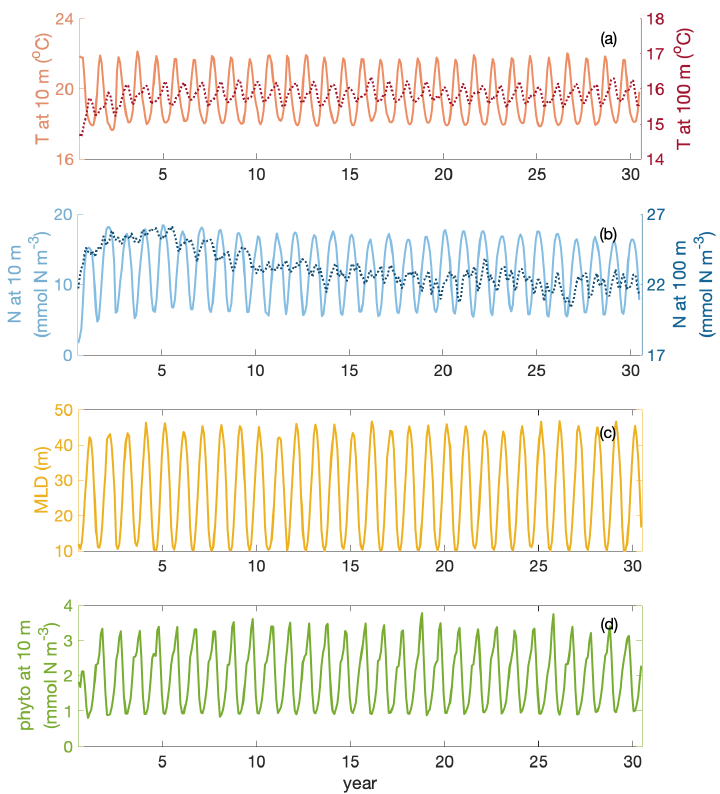
Figure C1. Time series of temperature T (at 10 and 100m depth), nitrate N (at 10 and 100m depth), mixed layer depth MLD and phyto- plankton phyto (at 10m) over 30 years of simulation in the focus